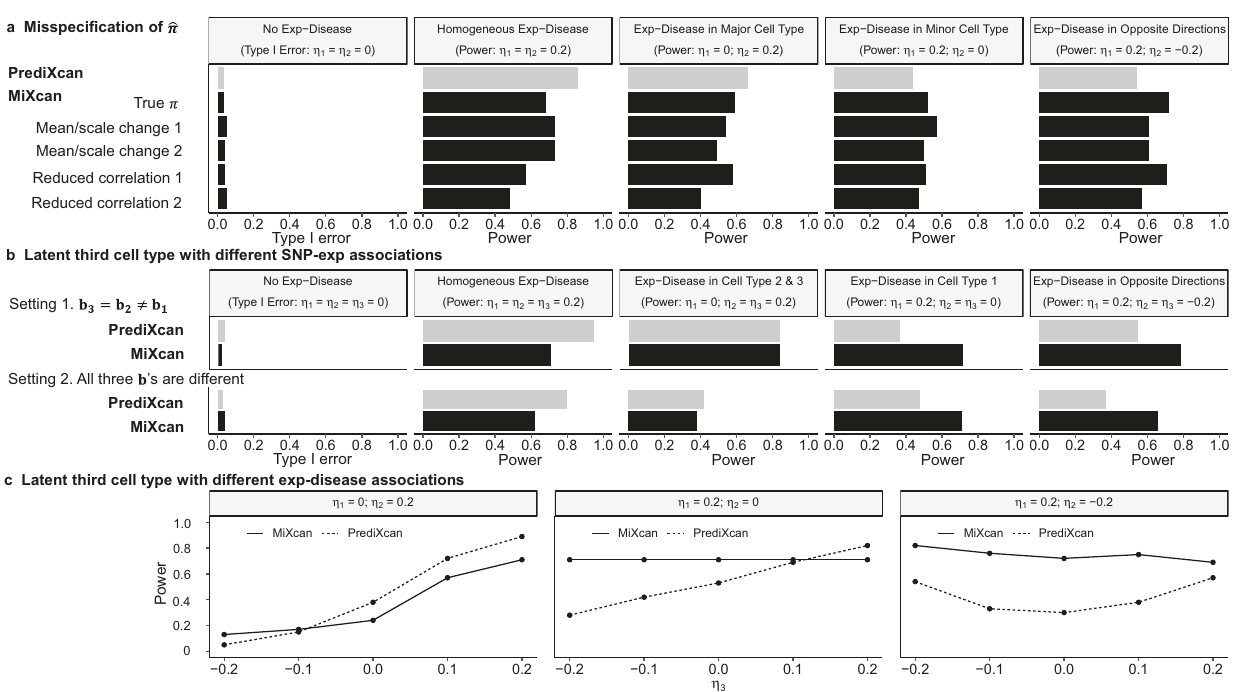
a latent third cell type contributes to SNP-Exp associations. MiXcan was assumed to decomposethetissueintotwocomponents,celltype1( π 1 =40%)vs.amixtureofcell types 2 ( π 2 = 50%) and 3 ( π 3 = 10%). In Setting 1, the SNP-Exp associations were the sameincelltypes3and2anddifferentincelltype1( b 3 = b 2 ≠ b 1 ).InSetting2,allthree cell types had different SNP-Exp associations ( b 3 ≠ b 2 ≠ b 1 ). c Study power fora tissue with a latent third cell type that contributes to Exp-Disease associations under three heterogeneous Exp-Disease settings where η 1 ≠ η 2 and η 3 varied from – 0.2 to 0.2. Source data are provided as a Source Data fi